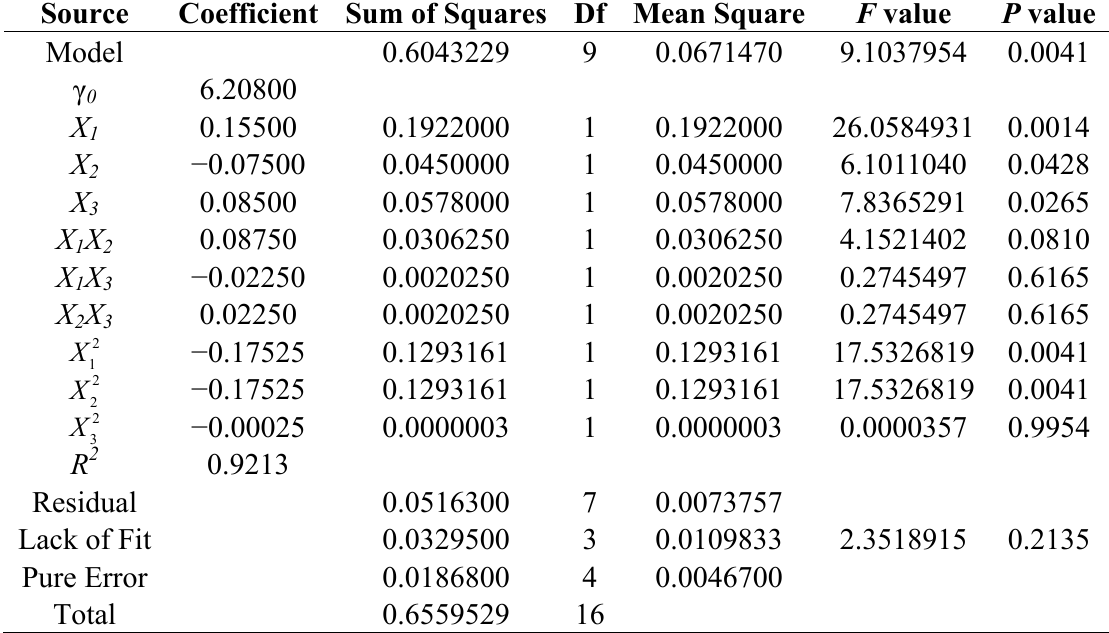
Table 2. The regression coefficients and results of ANOVA.